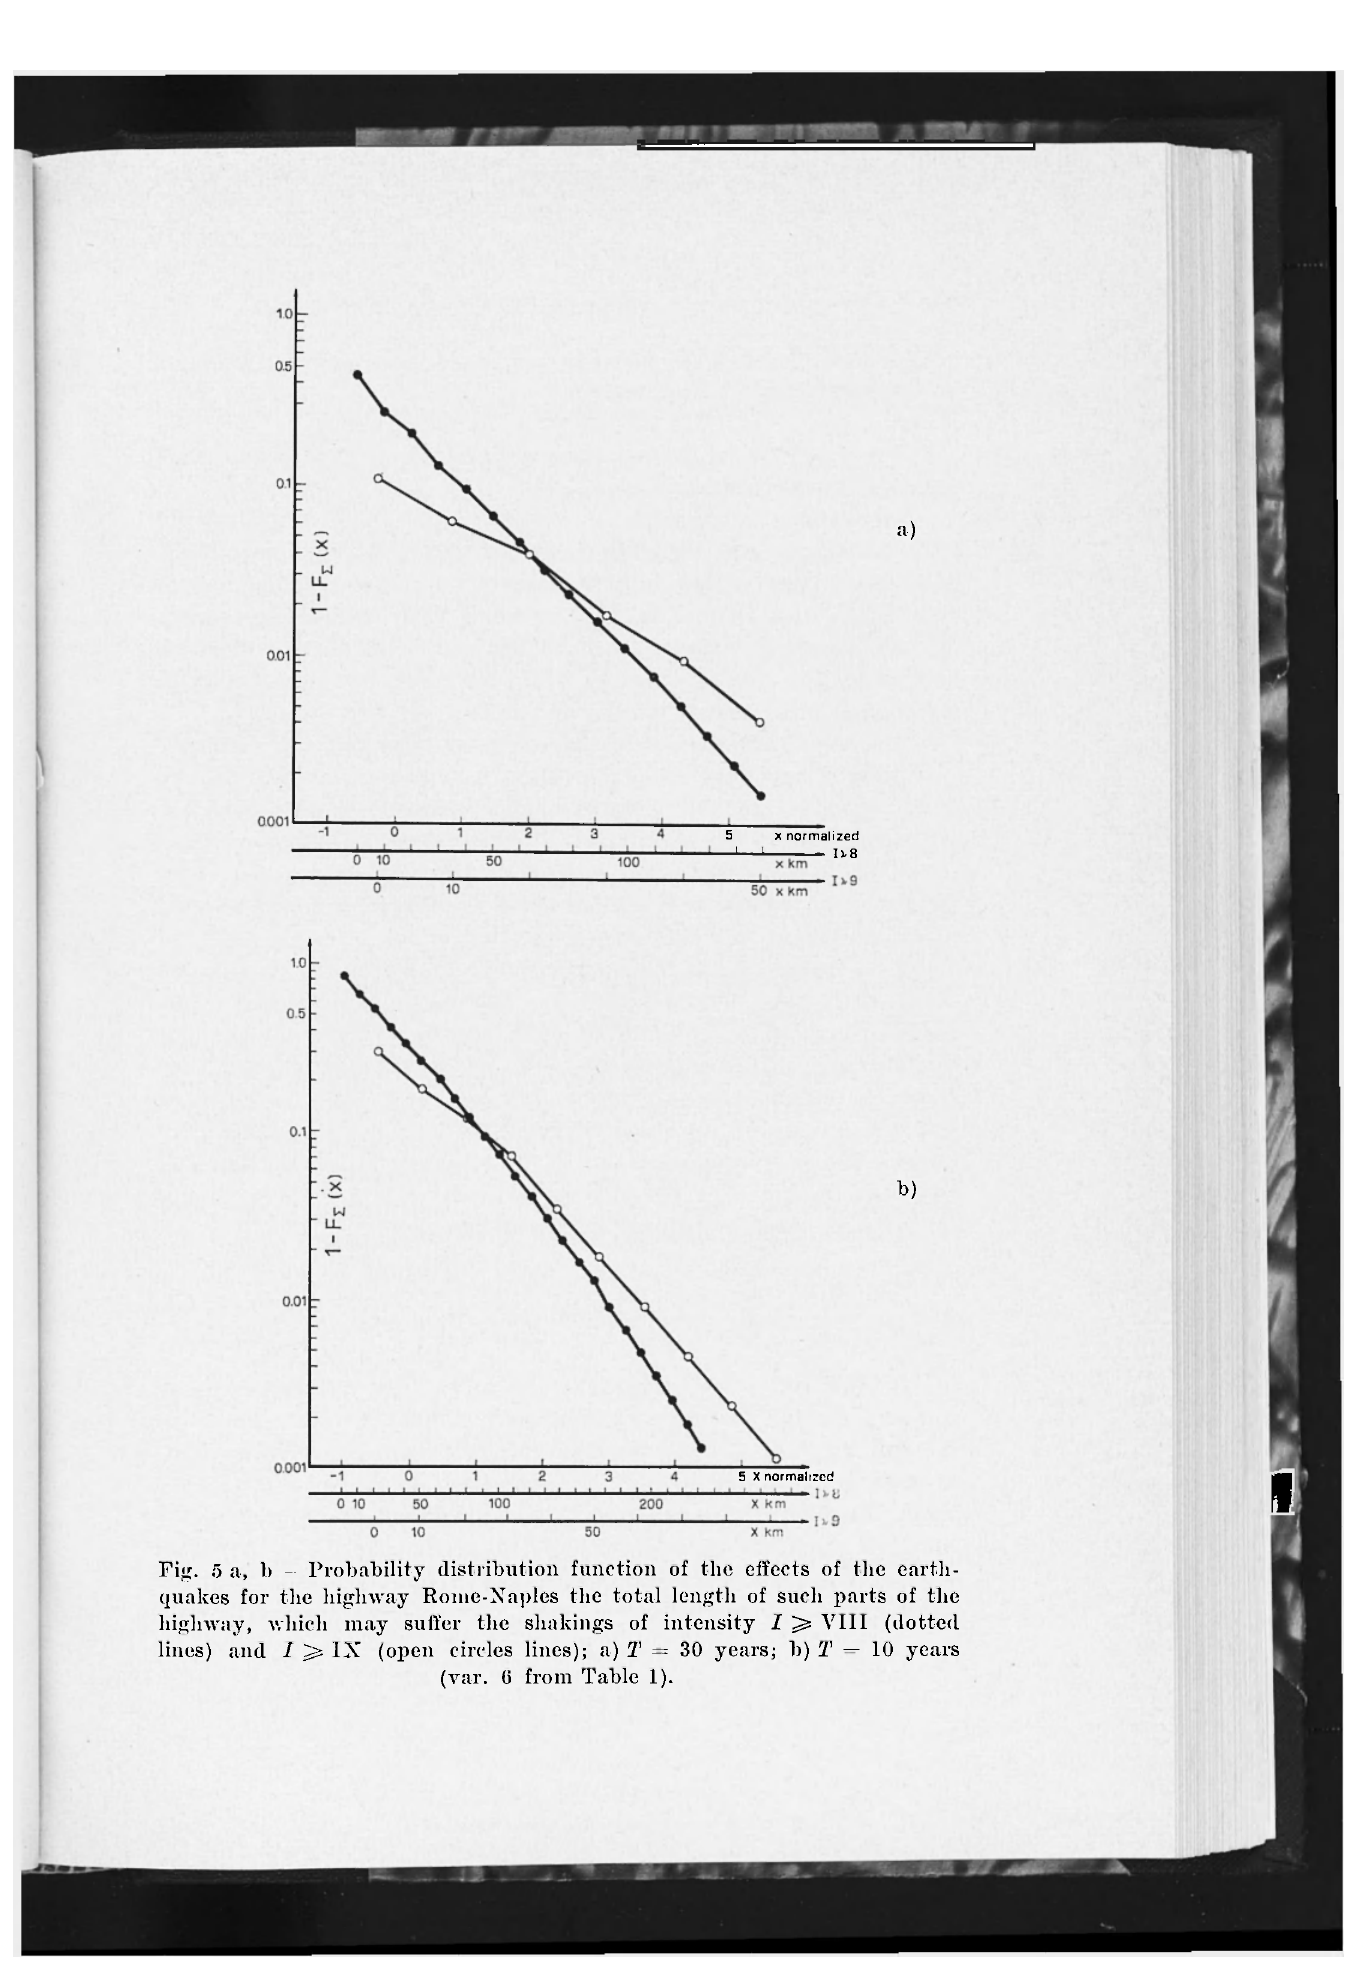
Fig. 5 a, b Probability distribution function of tlie effects of the earth- quakes for the highway Rome-Naples the total length of such parts of the highway, which may suffer the shakings of intensity I J; VIII (dotted lines) and I ^ IX (open circles lines); a) T = 30 years; b) T — 10 years (var. G from Table